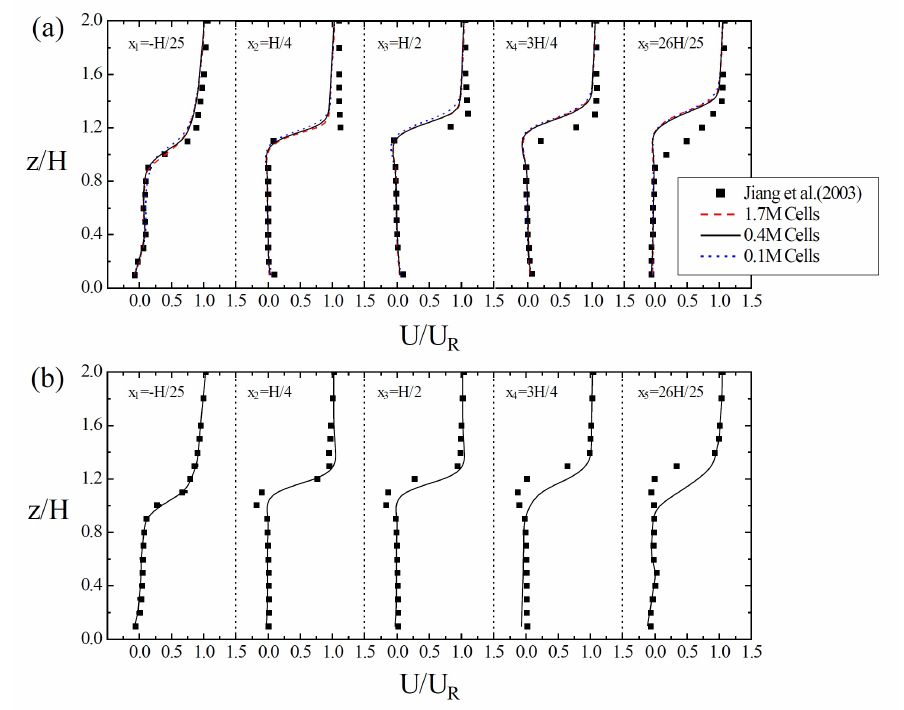
Figure 3. Comparison of velocity profiles along the direction normal to the wall with measurement data [2] at the measurement positions ( x 1 = − H /25, x 2 = H /4, x 3 = H /2, x 4 = 3 H /4 and x 5 = 26 H /25 ) for a single-sided building in ( a ) the windward and ( b ) leeward